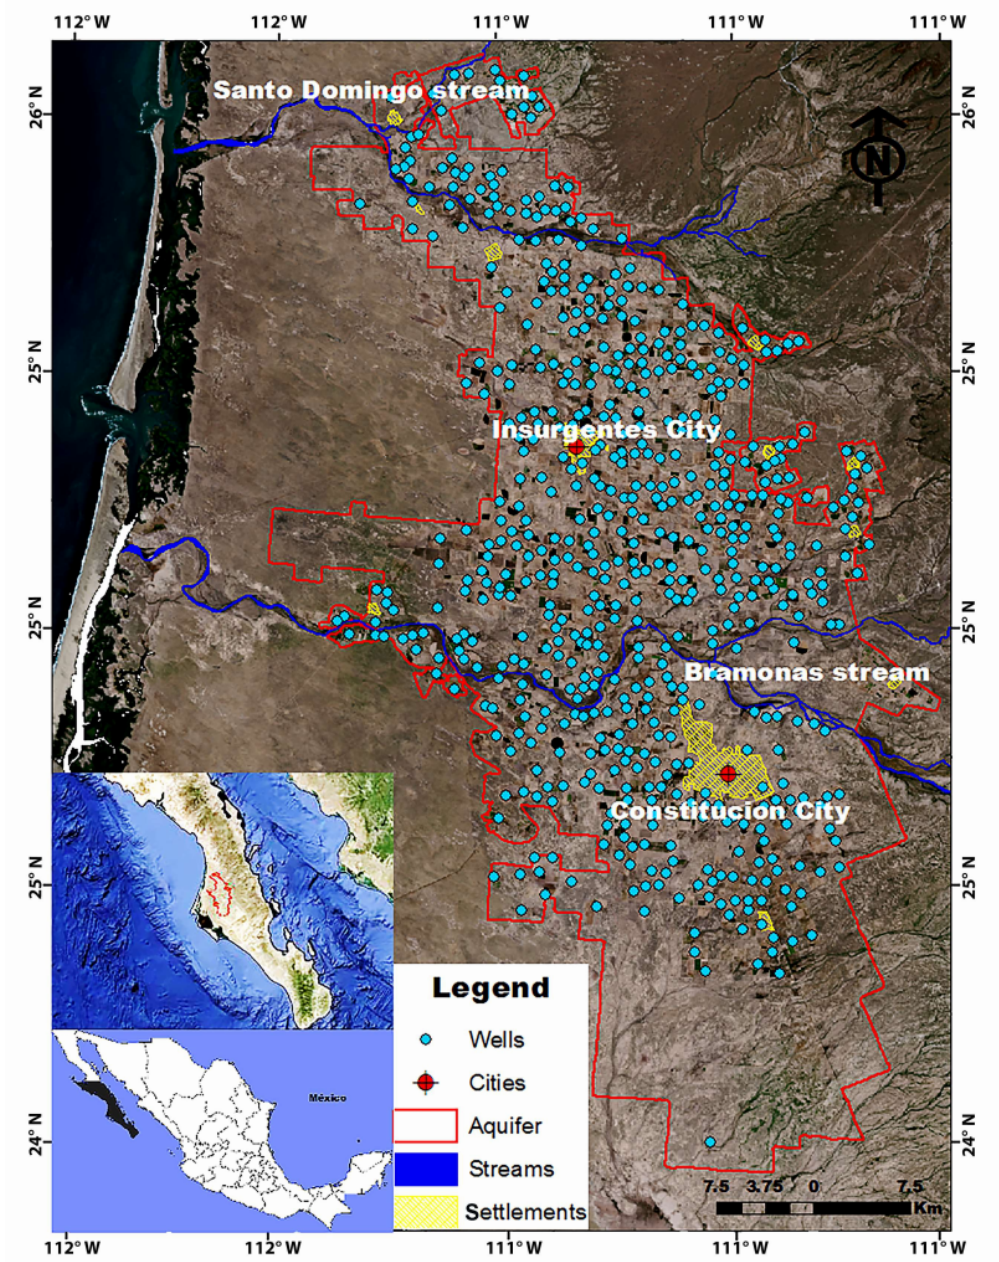
Figure 1. Location map of the study area showing the distribution and identification of sampled wells, main rivers, settlements and urban